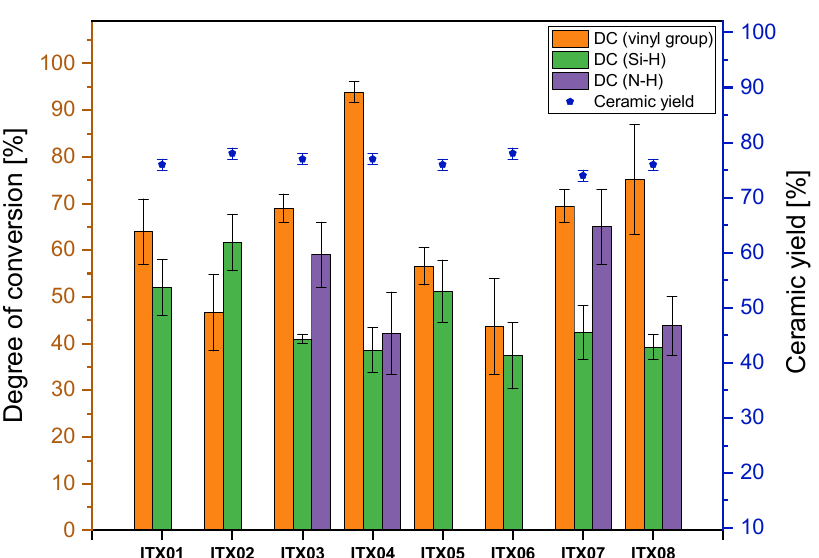
Figure 12. Degree of conversion of the reactive vinyl group as well as ≡ Si–H and N–H bonds calculated from the FTIR spectra of the samples ITX 01–08. The DC (N-H) of the samples cured in nitrogen atmosphere. The ceramic yield was obtained by TGA measurement at 1200 °C.